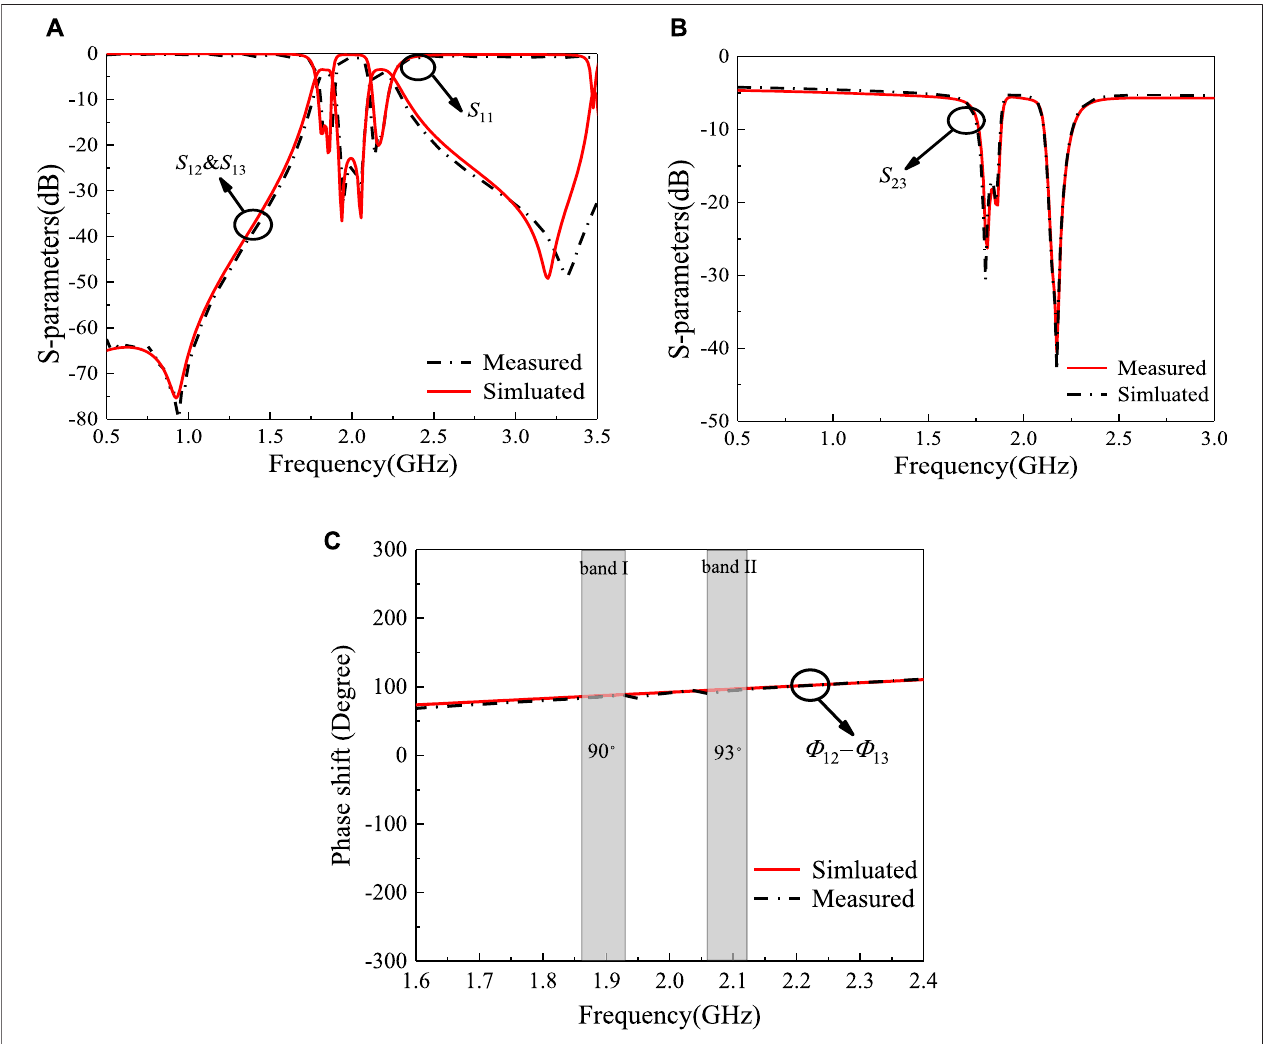
FIGURE 6 | Measured and simulated results of the proposed dual-band FPD. (A) Magnitudes of S 11 , S 12 , and S 13 . (B) Magnitudes of S 23 . (C) ∠ S 12 − ∠ S 13 .